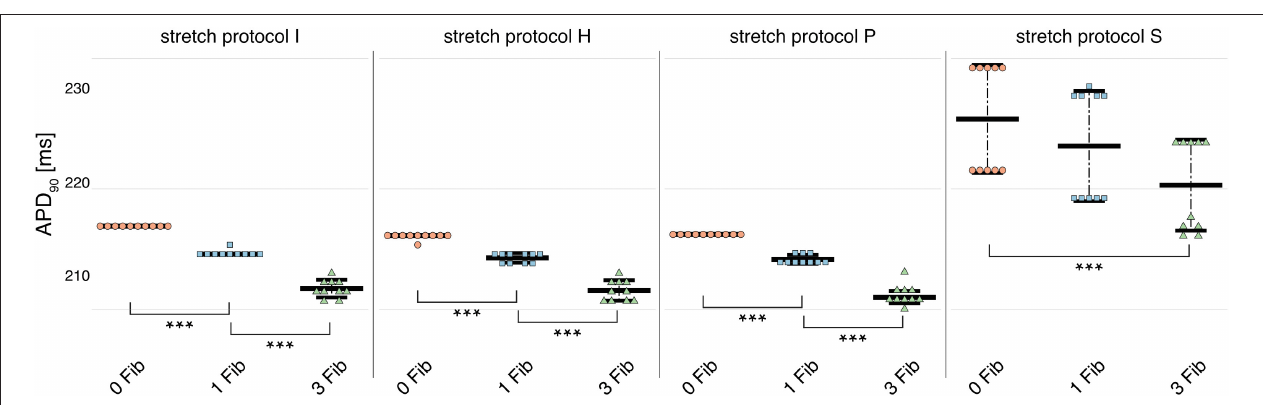
FIGURE 3 | (A) Membrane potential for stretch pattern S of myocyte 3 at Ca o = 4.0 mM and Ca o = 4.2 mM (from left to right). After one stimulated beat, at Ca o = 4.0 mM a calcium-mediated suprathreshold DAD occurred and at Ca o = 4.2 mM a calcium-mediated additional beat occurred followed by a calcium wave. (B) Associating calcium wave for the supratheshold DAD, and the additional beat followed by a calcium wave (from left to right) at Ca o = 4.0 mM and Ca o = 4.2 mM, respectively.